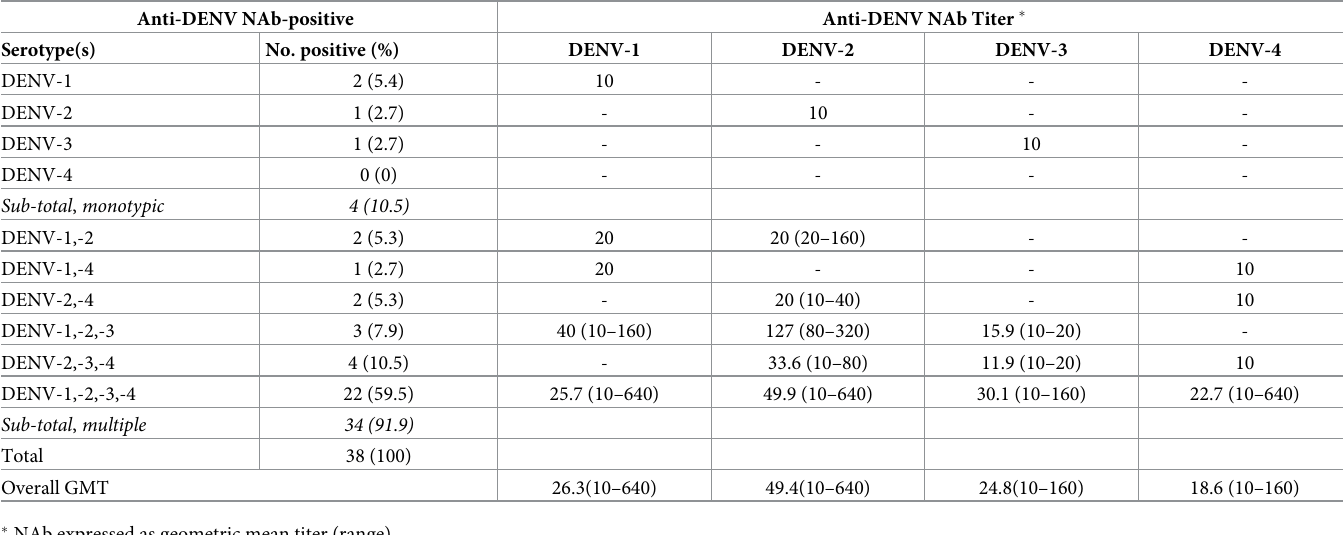
Table 5. Anti-DENV neutralizing antibody profiles, Lihir.